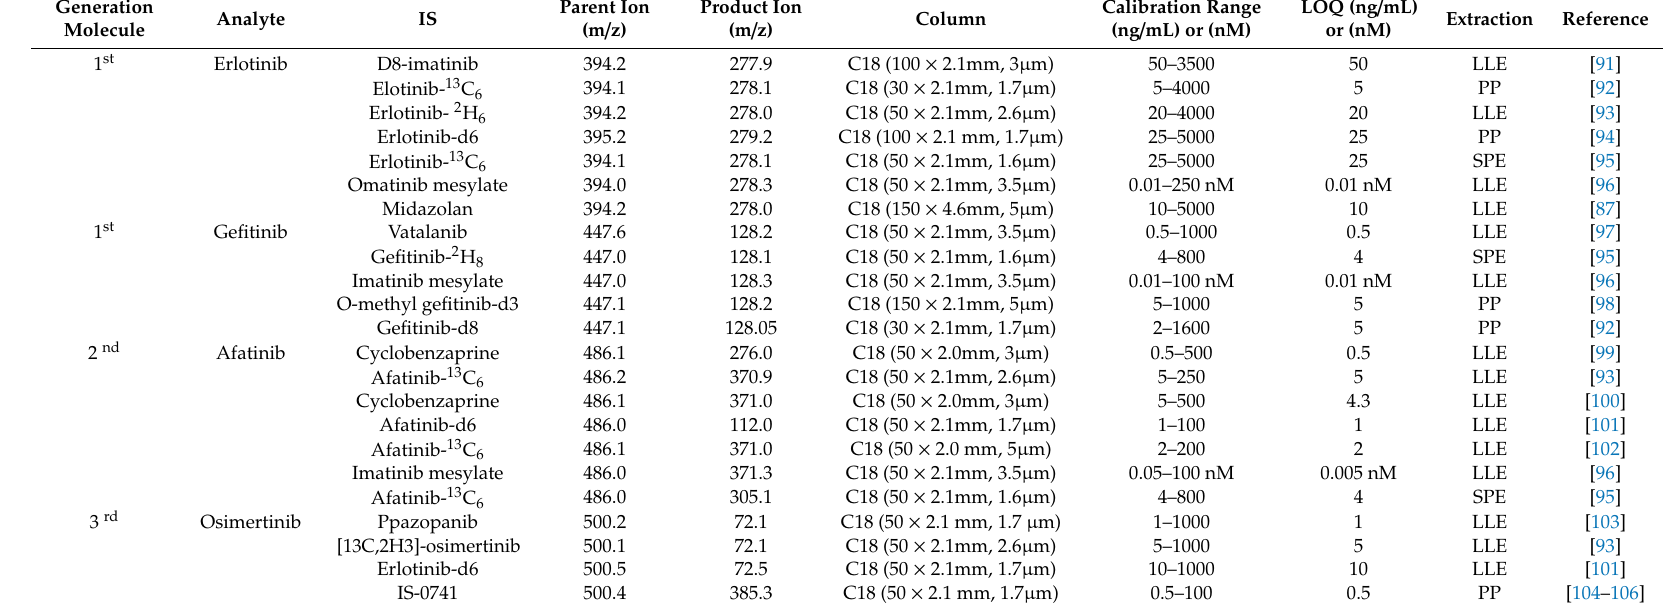
Table 3. LC-MS / MS methods for the quantification of the 4 TKI in human